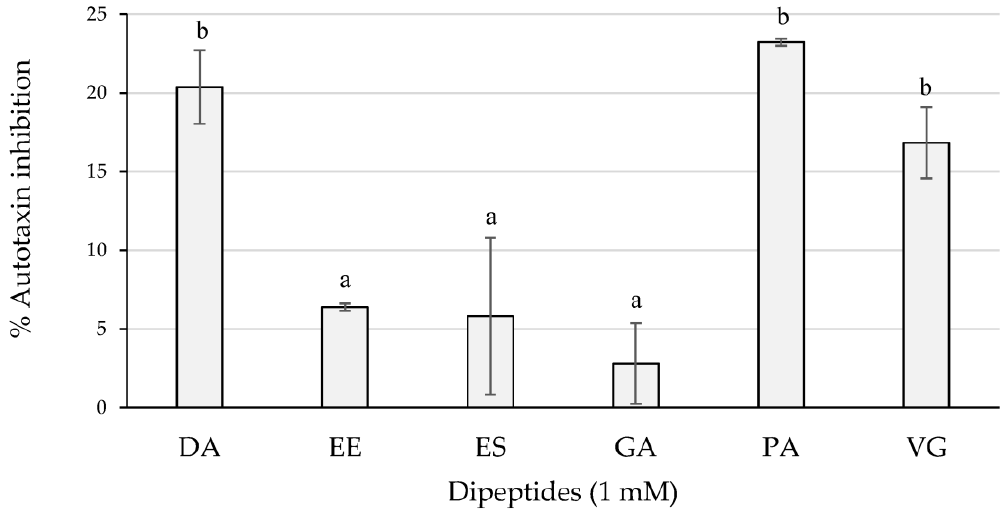
Figure 3. Autotaxin inhibition percentages of the dipeptides DA, EE, ES, GA, PA, and VG (DG was null), identified in 12 months dry-cured ham extracts with low-salt content, at 1 mM ( n > 3). Different letters indicate statistically significant differences ( p < 0.05) between inhibitory activities. Reproduced from [100] with permission.